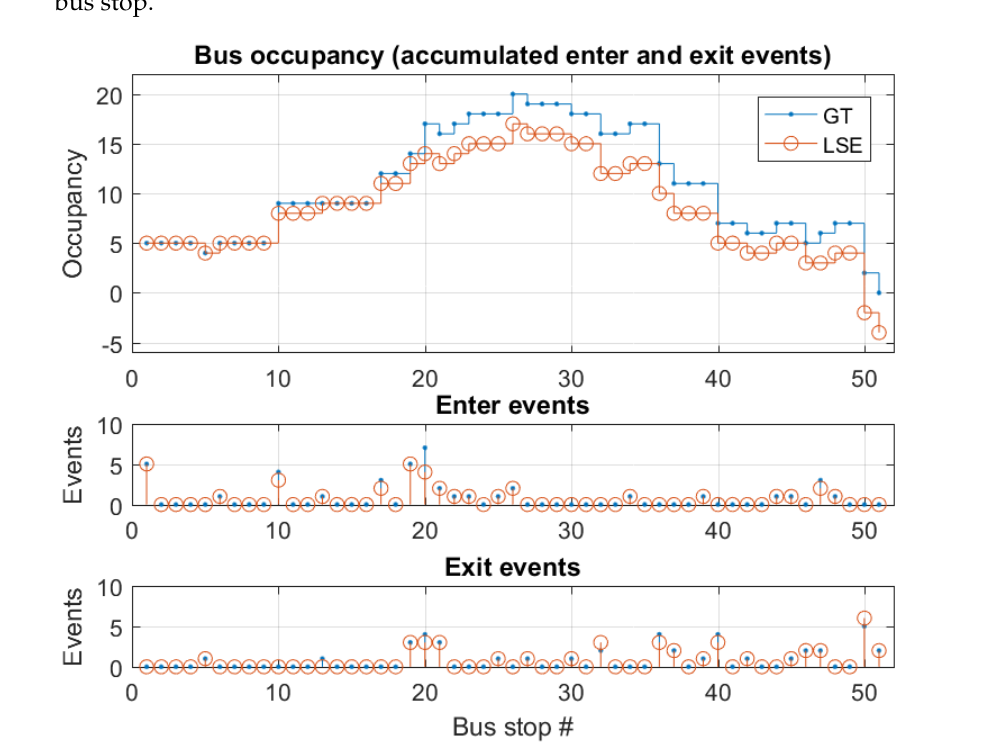
Figure 5. Top: Busoccupancy GT and LSE per bus stop. Middle: enter events per bus stop. Bottom: exit events per bus stop. Based on dataset 2